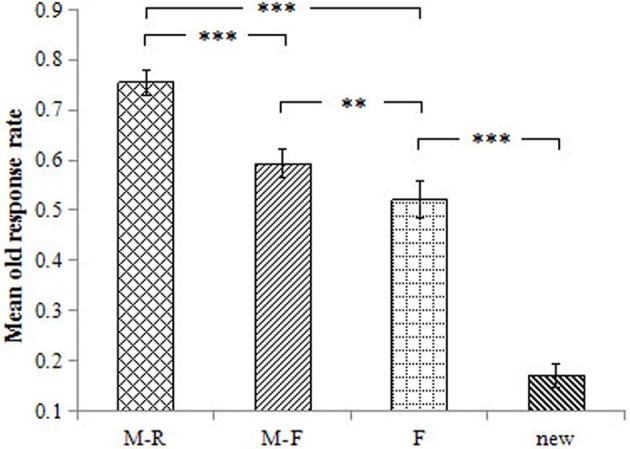
Mean old response rate for the different conditions. Error bars represent standard error of the mean. ***p < 0.001, **p < 0.01.